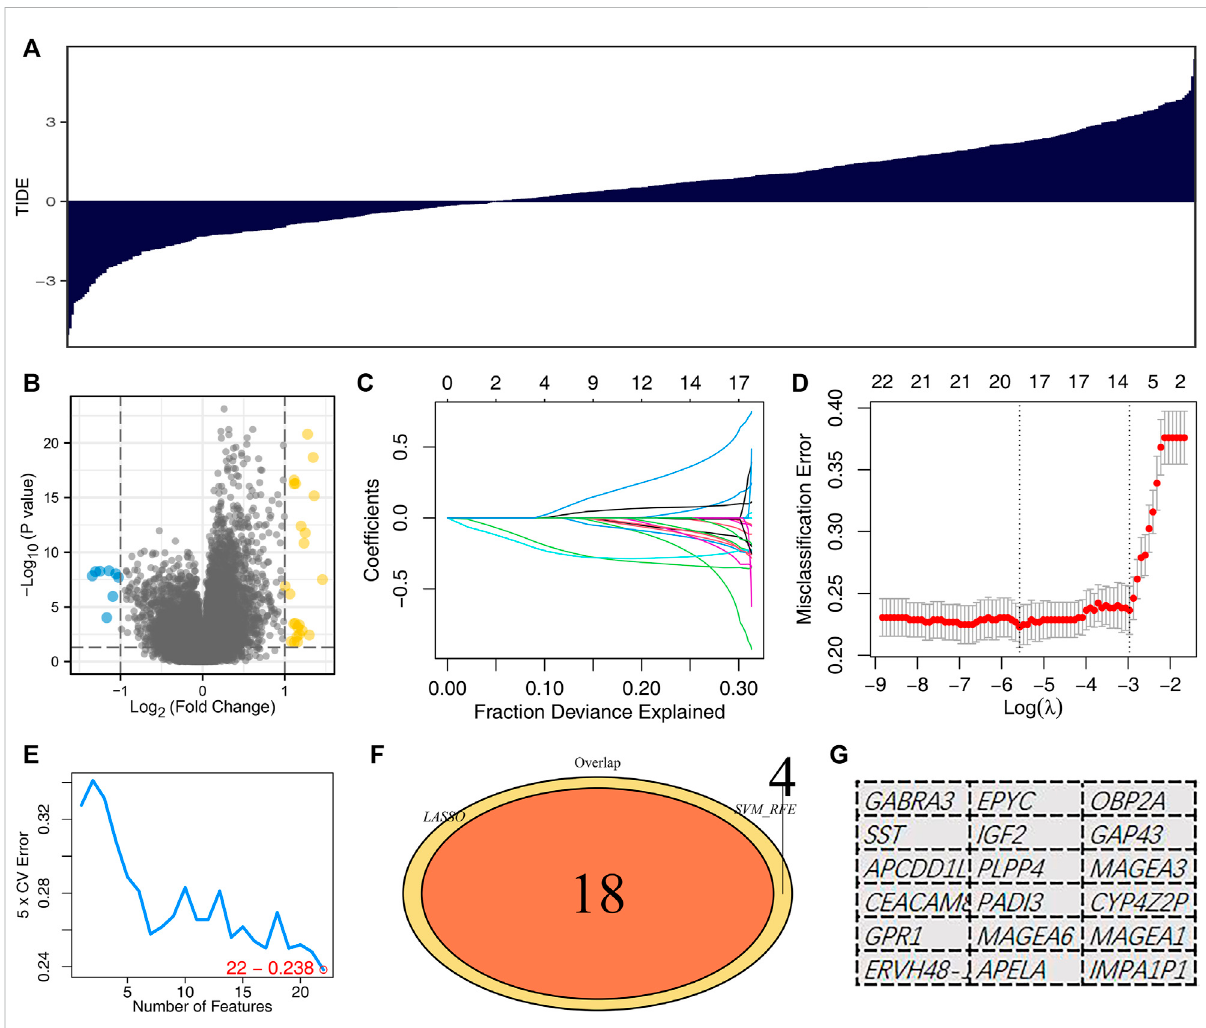
FIGURE 1 Identi fi cation of the immunotherapy characteristic genes. Notes: (A) TIDE analysis was performed to evaluate the immunotherapy response of each patient. (B) Volcano plots depicted differentially expressed genes between immunotherapy responders and non-responders; ( C,D) : LASSO logistic regression analysis based on differentially expressed genes between immunotherapy responders and non-responders. (E) SVM-RFE analysis based on differentially expressed genes between immunotherapy responders and non-responders; ( F,G) : The intersection of LASSO logistics regression and SVM-RFE algorithms identi fi ed 18 immunotherapy characteristic